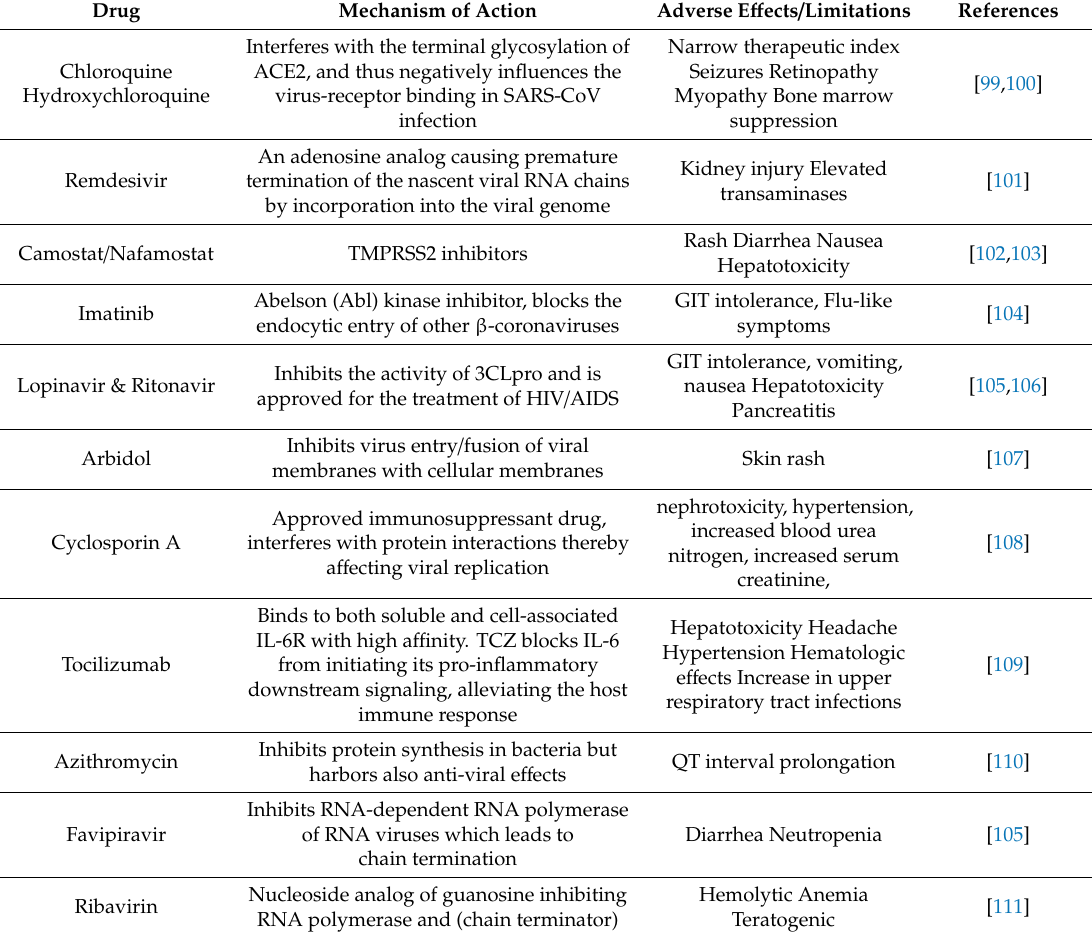
Table 2. Proposed drugs for the COVID-19 infection treatment